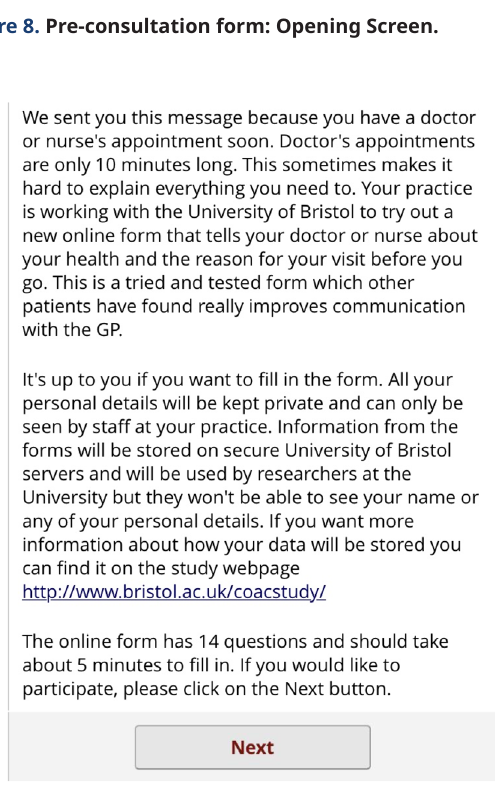
Figure 9. Pre-consultation form: Information and consent screen.